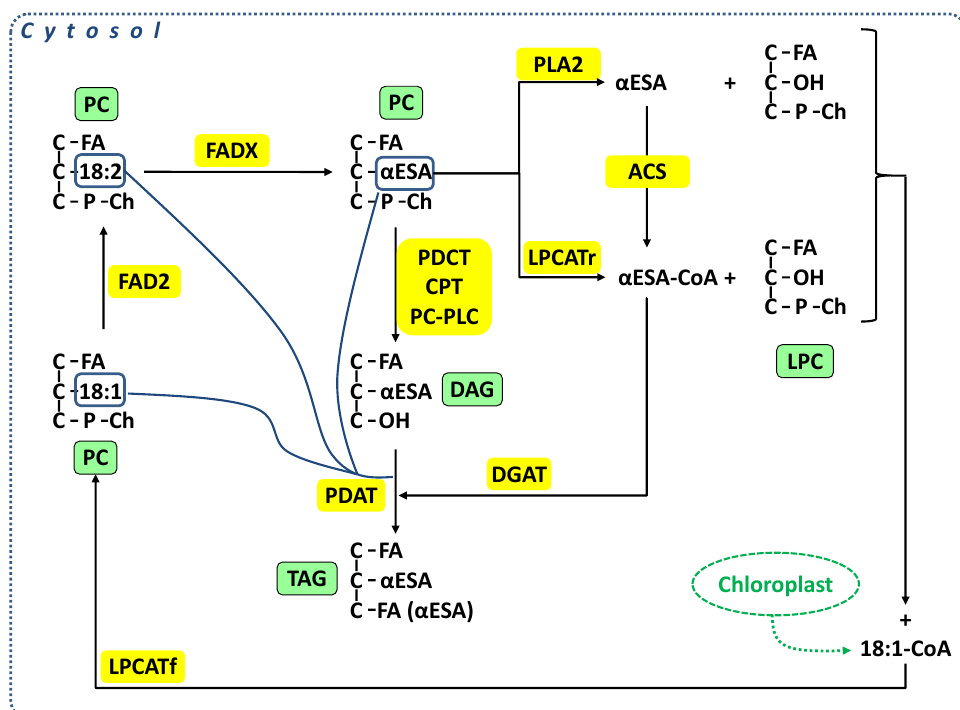
Scheme 1. Biosynthesis of αESA and po tential ways of its transfer from PC to TAG. PC —